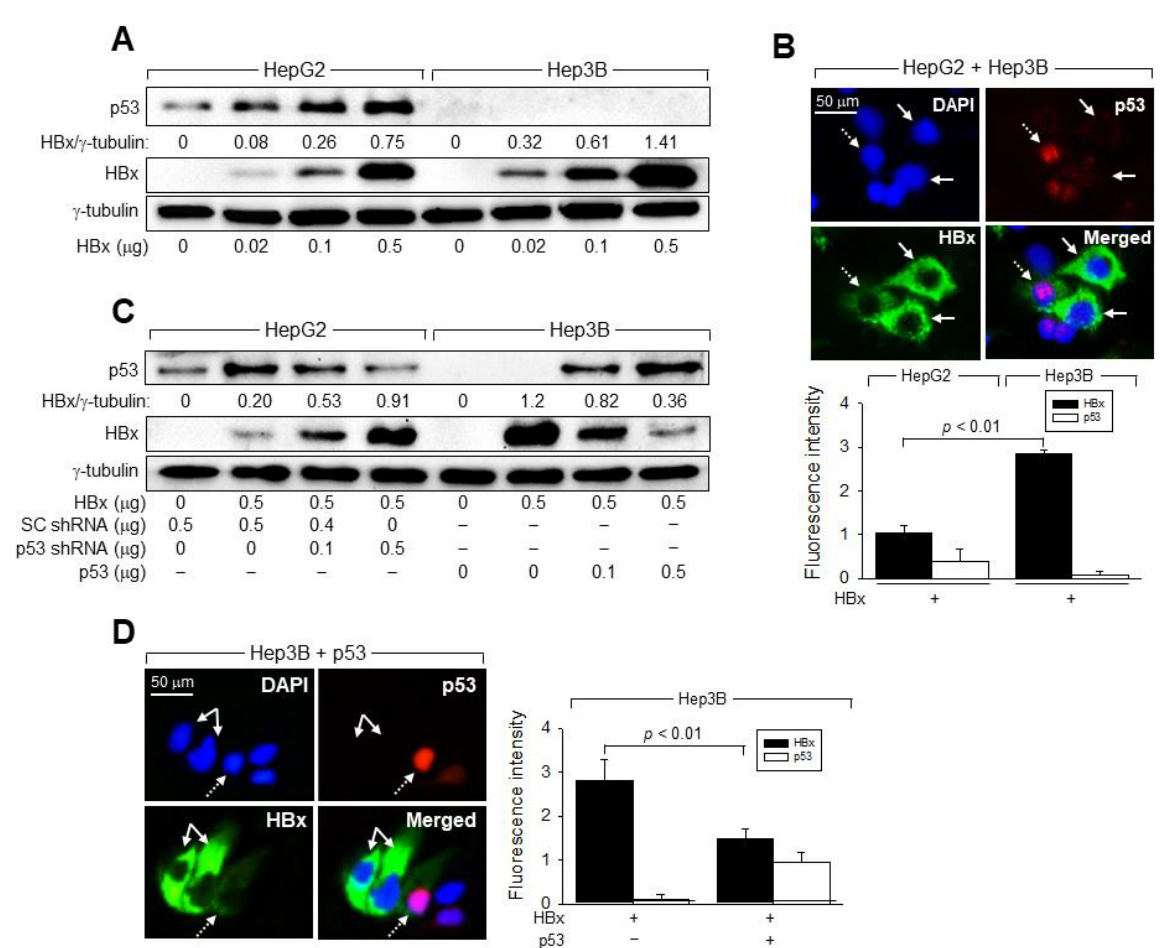
Figure 5. p53 downregulates HBx expression in human hepatoma cells. ( A ) HepG2 and Hep3B cells were transiently transfected with increasing concentrations of HBx expression plasmid for 48 h, followed by Western blotting. Each band was quantified using ImageJ image analysis software (NIH, Bethesda, MD, USA), and the values indicate the levels of HBx relative to the loading control ( γ -tubulin). ( B ) An equal number of HepG2 and Hep3B cells grown on coverslips were transiently transfected with HBx expression plasmid for 48 h. Cells were fixed, incubated with anti-HBx monoclonal and anti-p53 polyclonal antibodies, and then incubated with anti-mouse IgG-FITC and anti-rabbit IgG-rhodamine antibodies to visualize HBx (green) and p53 (red), respectively. Nuclei (blue) were stained with 4 (cid:48) , 6-diamidino-2-phenylindole (DAPI). Representative images are shown. Hep3B cells expressing HBx are shown as straight arrows, whereas one HepG2 cell expressing both HBx and p53 is indicated with a broken arrow. The fluorescence intensity was analyzed using ImageJ image analysis software ( n = 3). Scale bar = 50 µ m. ( C ) HepG2 and Hep3B cells were transiently transfected with the HBx expression plasmid along with SC shRNA, p53 shRNA, or p53 expression plasmid for 48 h, followed by Western blotting. ( D ) Hep3B cells were co-transfected with HBx and p53 expression plasmids for 48 h. Cells were subjected to double-label indirect immunofluorescence assays as described in ( B ) to visualize HBx (green) and p53 (red). Hep3B cells expressing HBx are shown with straight arrows, whereas cells expressing both HBx and p53 are indicated by broken arrows. The fluorescence intensity was analyzed using ImageJ image analysis software ( n = 3). Scale bar = 50 μ m.